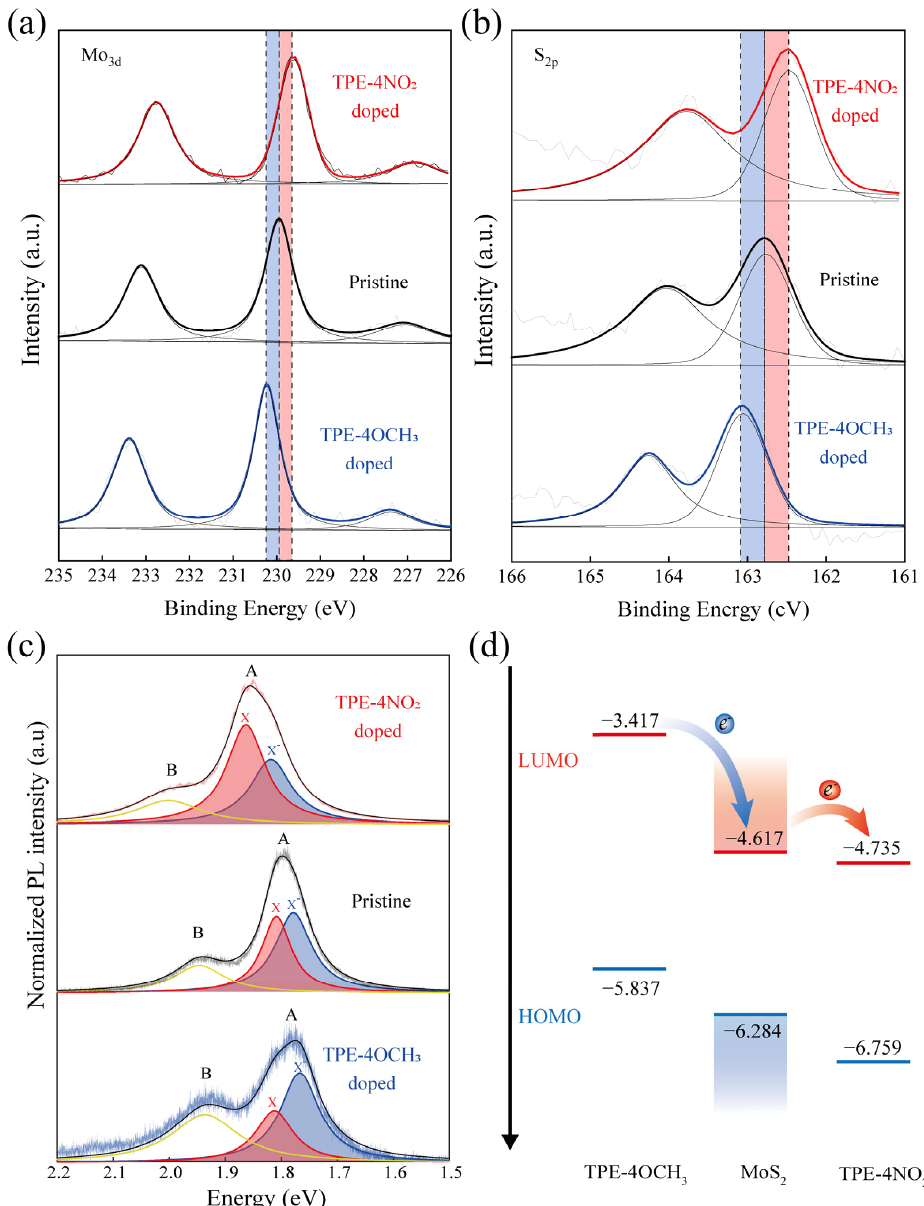
Figure 3. XPS spectra of Mo 3d ( a ) and S 2p ( b ) for pristine and doped MoS 2 samples. ( c ) Normalized PL intensity for pristine and doped samples of monolayer MoS 2 by the fitting of Lorentz peaks. ( d ) Energy band structure of MoS 2 , TPE-4OCH 3 and TPE-4NO 2 .